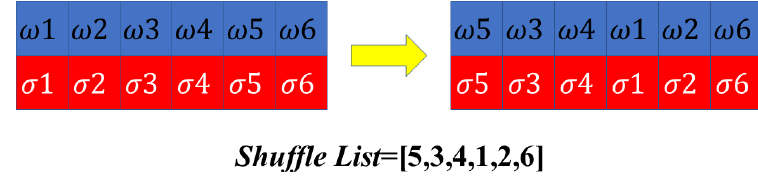
Figure 8. Shuffle Learning Strategy.